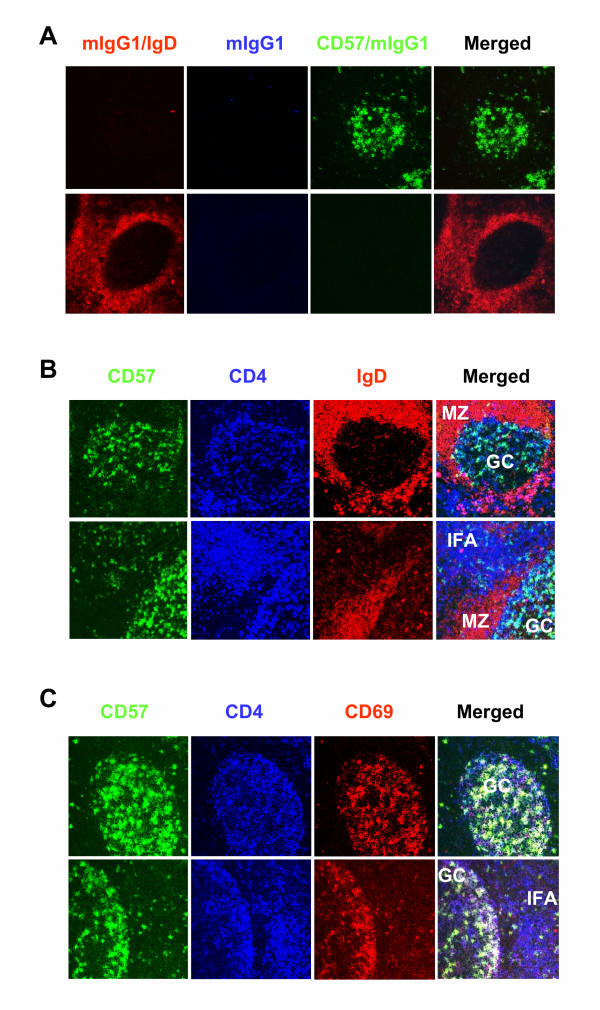
Distribution of CD4+ T helper cells in tonsils. Frozen tonsil sections were stained with anti-IgD (PE, red) or anti-CD57 (FITC, green) and isotype control antibodies in panel group A to show the background staining of the system. In panel group B, sections were stained with anti-CD57 (FITC), anti-IgD (PE) and anti-CD4 (APC). In panel group C, sections were stained with anti-CD57 (FITC), anti-CD69 (PE) and anti-CD4 (APC). Two different sections were shown in each group of panels. Stained sections were analyzed with a confocal microscope. GC-Th cells can be divided into CD57+ and CD57- T cells, both of which are CD69+. A few CD69+ or CD57+ T cells are found outside of GC. Most CD4+ T cells in the interfollicular areas (IFA or T cell-rich zone) are CD57- and CD69-. GCs are surrounded by the ring of mantle zones (MZ) filled with IgD+ cells. A representative set of images from three different specimens are shown.